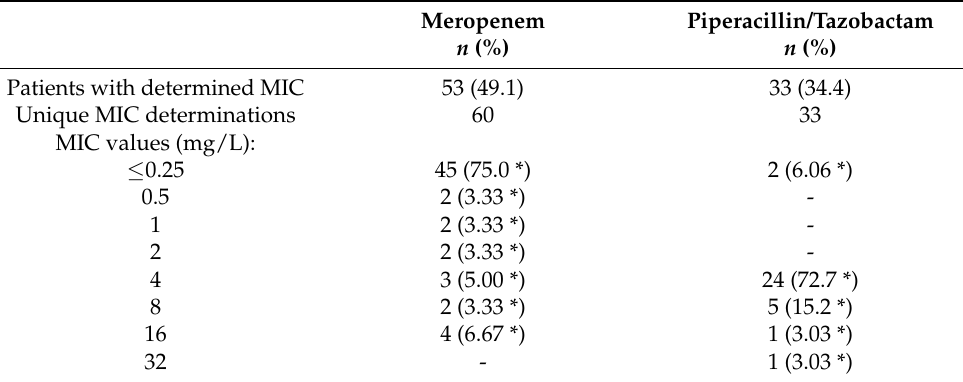
Table 2. Observed minimum inhibitory concentration (MIC)